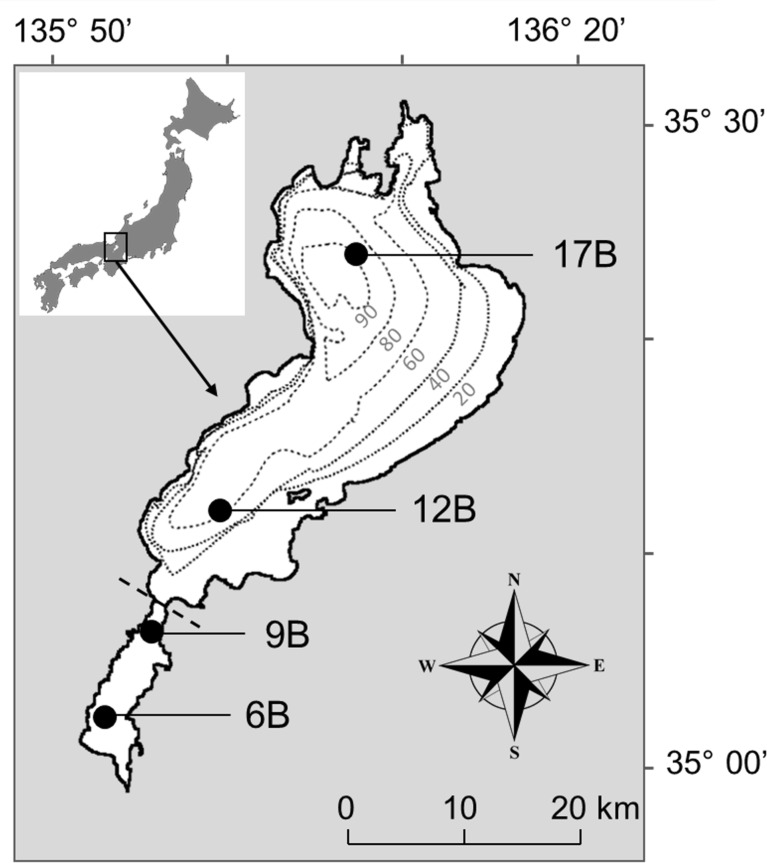
Map of study sites in Lake Biwa, Japan.Stations 6B and 9B represent the South Basin, while Stations 12B and 17B were selected as representatives of the North Basin. Grey dotted lines indicate the isobaths (in m), and dashed line represents the boundary of the basin. This figure was reproduced from the website of the Geospatial Information Authority of Japan (https://www.gsi.go.jp) and supplemented with latitude and longitude lines. This map is licensed under the Government of Japan Standard Terms of Use (Ver.2.0). The Terms of Use are compatible with the Creative Commons Attribution License 4.0 (CC BY 4.0).